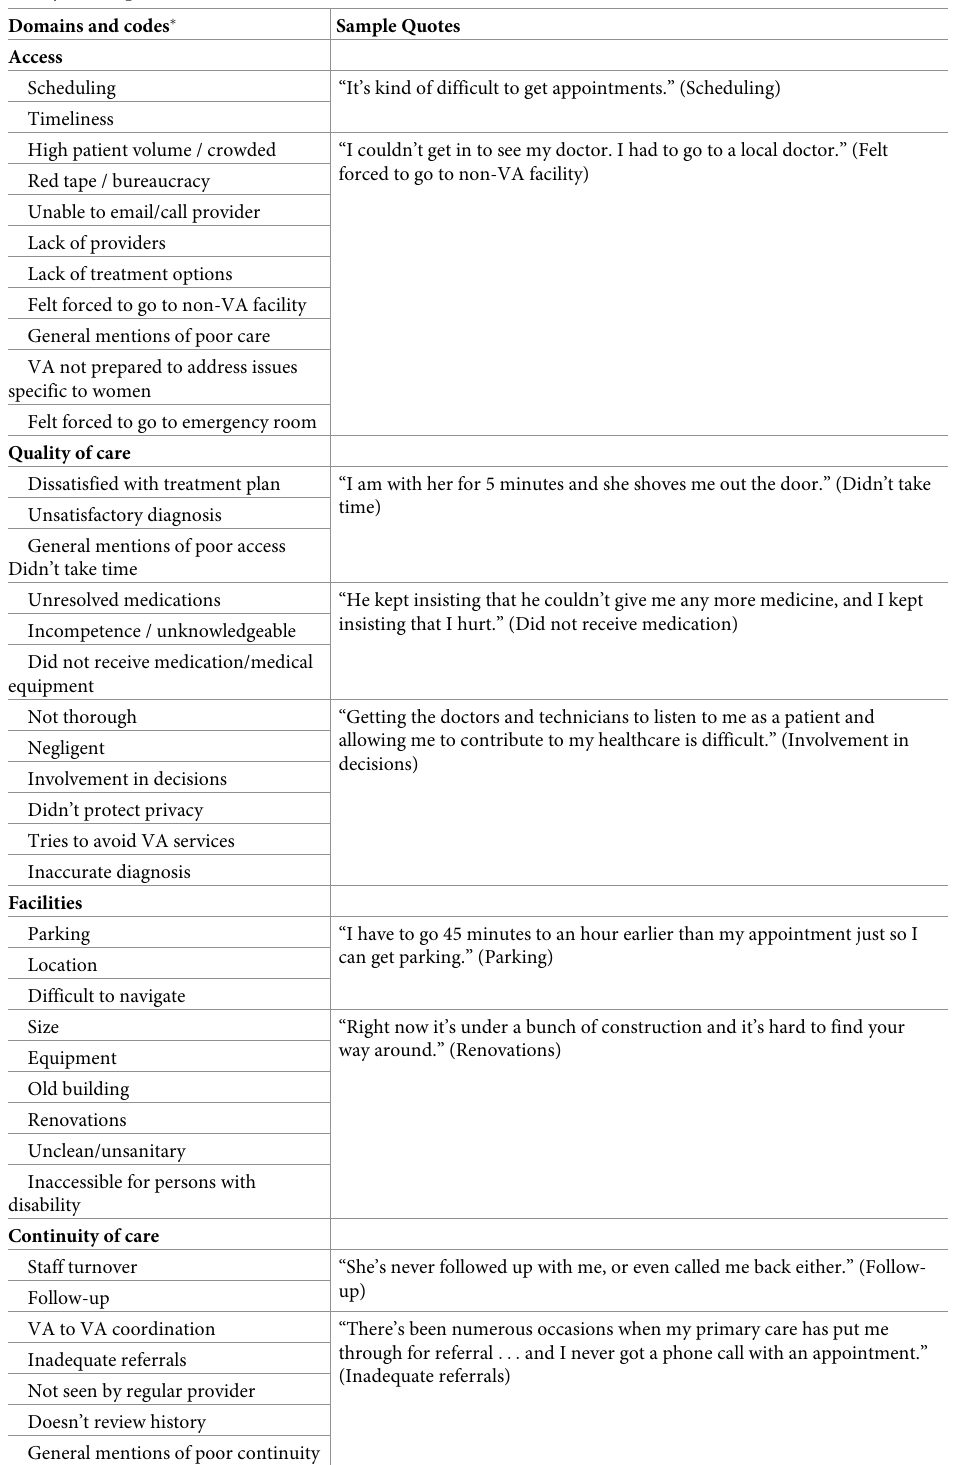
Table 1. Domains of dissatisfaction with healthcare experiences and related codes derived from semi-structured surveys about patient